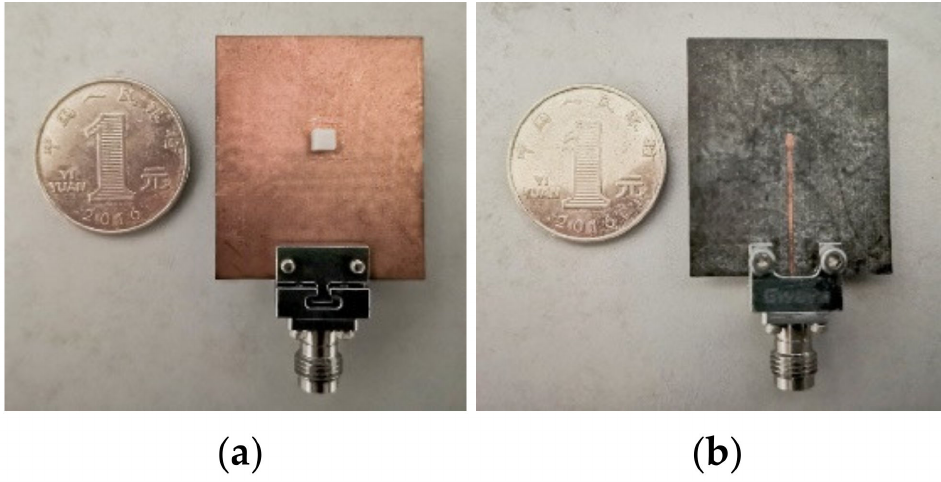
Figure 9. Photographs of the fabricated prototype: ( a ) Top view; ( b ) Bottom view.